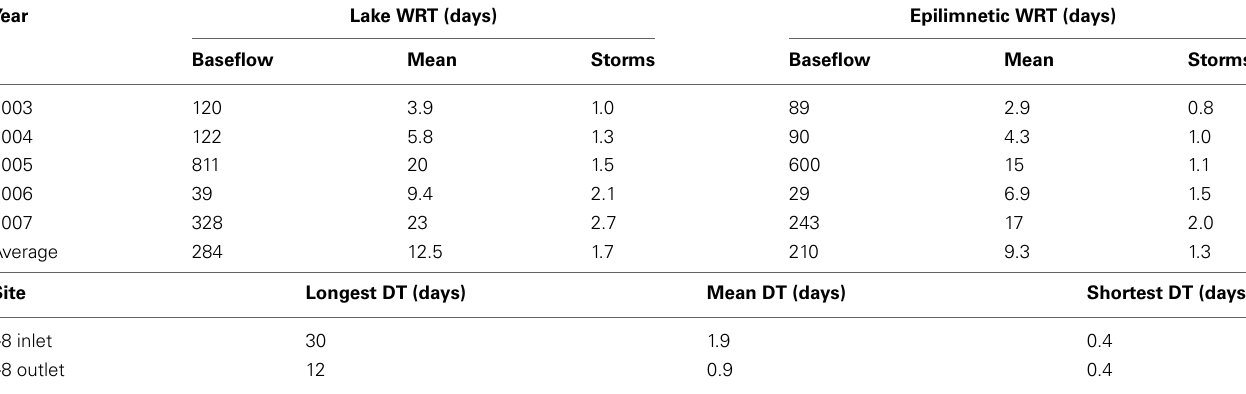
Table 2 | Water residence time (WRT) for Lake I-8 and doubling times (DT) for I-8 inlet and outlet bacteria, based on data from 2003 to